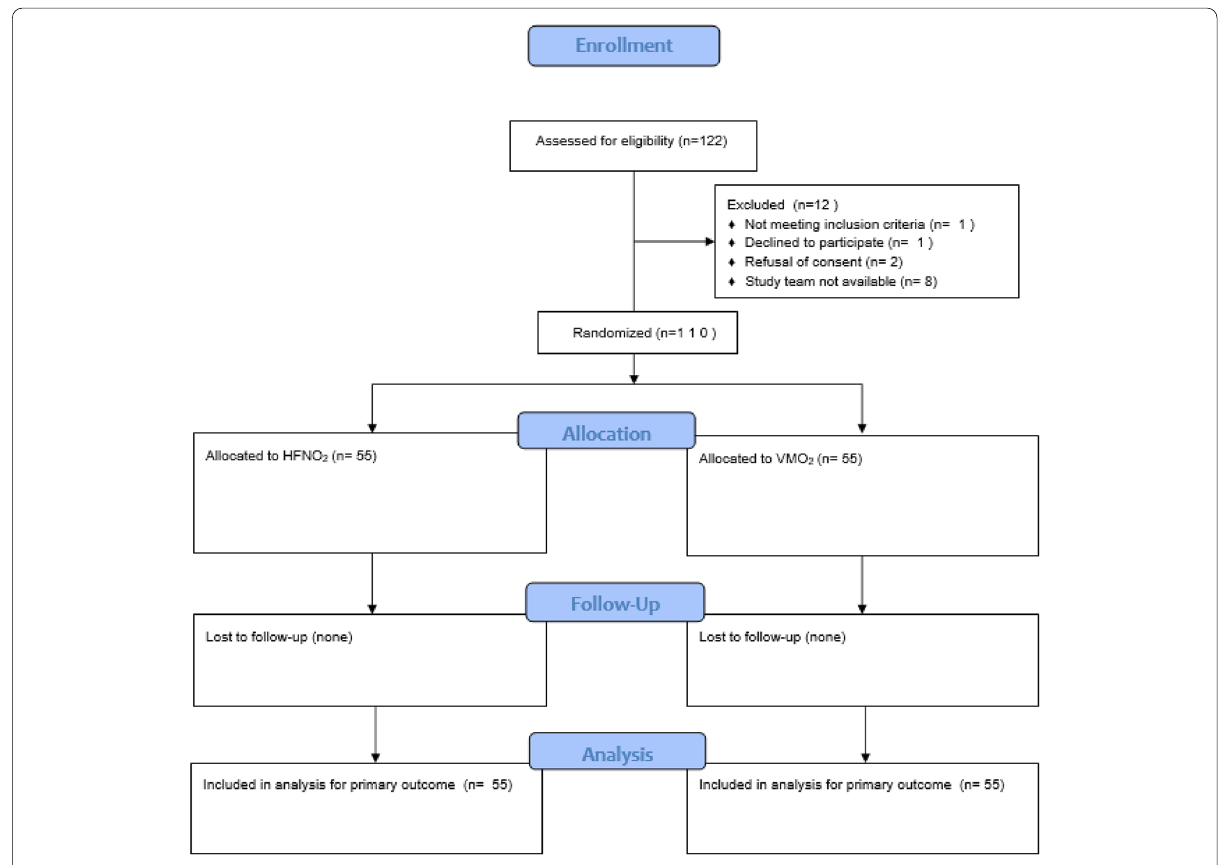
Fig. 3 Flow chart for patient enrollment